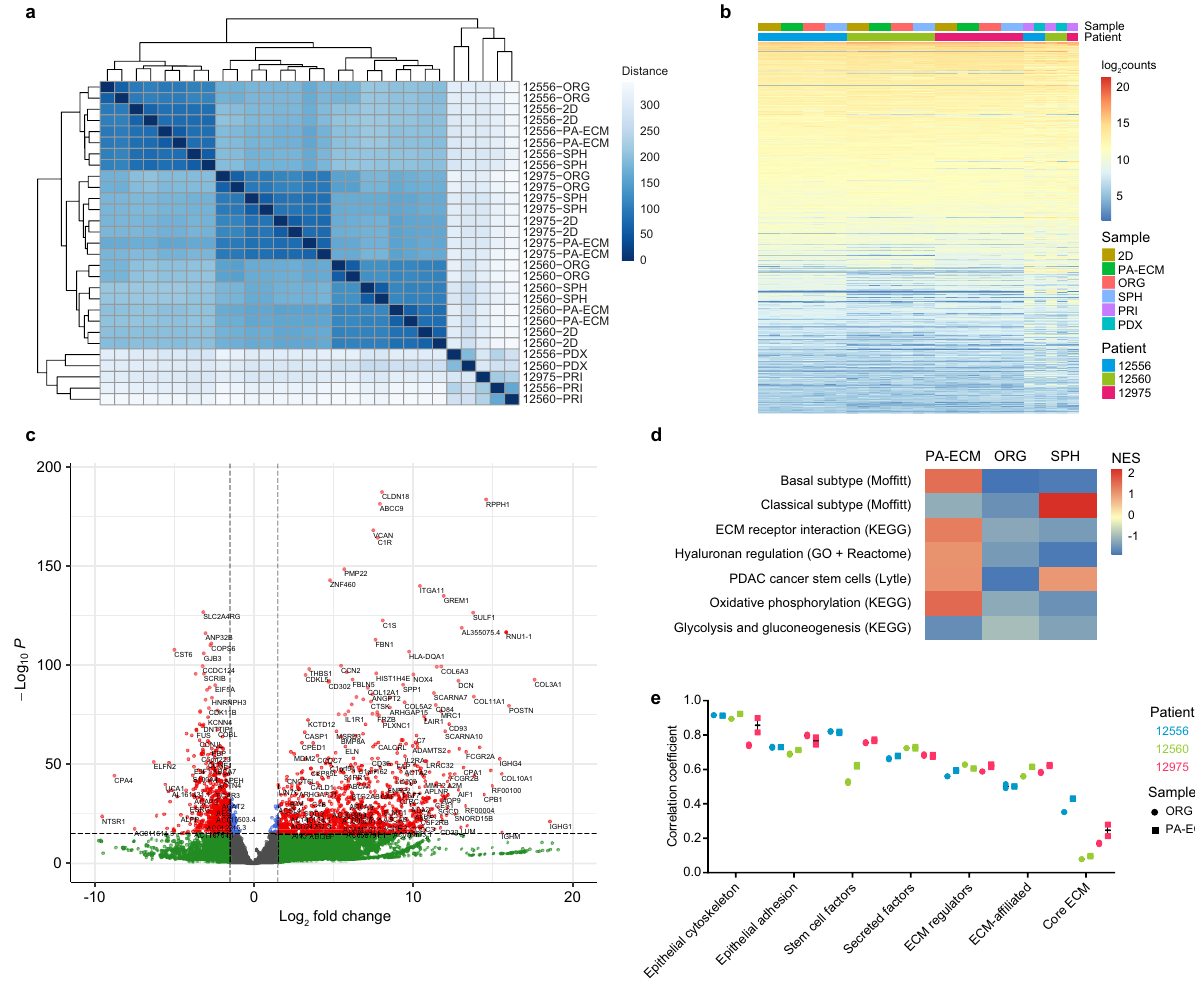
Fig. 3 Transcriptomic analysis of ex vivo models of PDAC. a Hierarchically clustered distance matrix of the PDAC samples analysed by RNA sequencing. Distance is shown in colour-coded arbitrary units. b Regularised log 2 expression of the top 20,000 genes expressed in all samples. c Volcano plot showing gene enrichment in primary tumours compared to PA-ECM monocultures, with correction for interpatient differences. d Heatmap depicting pathways identi fi ed by gene set enrichment analysis that are up- or downregulated in 3D models with respect to 2D monolayers. Normalised enrichment scores (NES) are colour-coded. e Correlation of epithelial and matrisome gene list expression between primary PDAC tissues and their corresponding organoids and PA-ECM cultures. Mean and range are shown for two biologically independent replicates per sample type. ORG organoids, SPH spheres, PRI primary